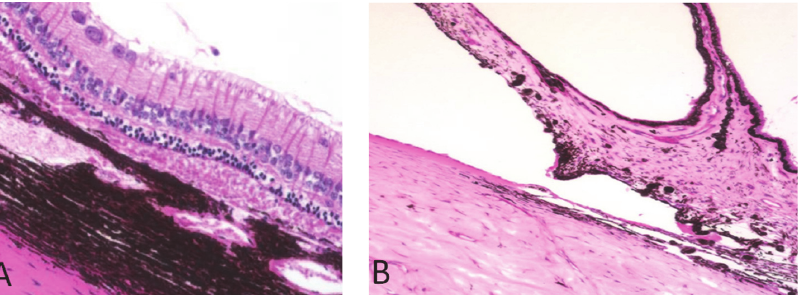
Figure 3: (A) Light microscopy of the retina 6 months after intravitreal injection of pNIPAM. The ganglion cell layer is facing upwards. Signs of retinal toxicity such as inner or outer retinal atrophy were not detected. (B) Light microscopy of the anterior chamber 6 months after intravitreal injection of pNIPAM. The iris tissue is facing upwards. The iris and the anterior chamber angle showed no abnormalities or